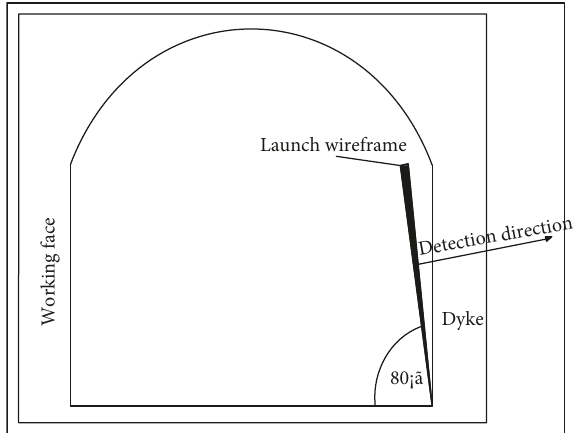
Figure 18: Layout of the detection